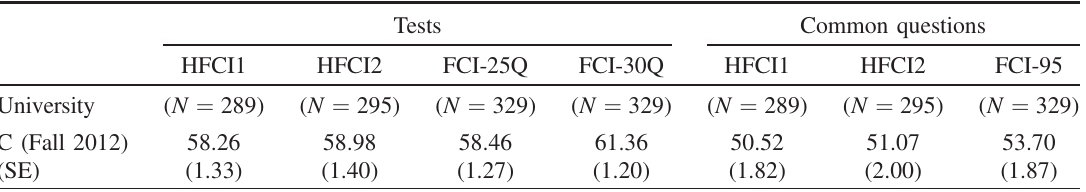
TABLE IV. Mean HFCI and FCI scores at university C. Scores for each test version are given: HFCI1, HFCI2, FCI-25Q (FCI-95 with five questions not used on either HFCI omitted), FCI-30Q (full FCI-95). FCI-30 scores are slightly higher than the HFCI scores, but if the five questions not used in either HFCI are omitted, the FCI-25 score falls in between the two HFCI scores. Scores on the three questions (FCI questions 2, 26, and 28) common to all versions of the test are higher in the FCI than in either HFCI. Standard error (SE) and sample size ( N ) are listed for each score.